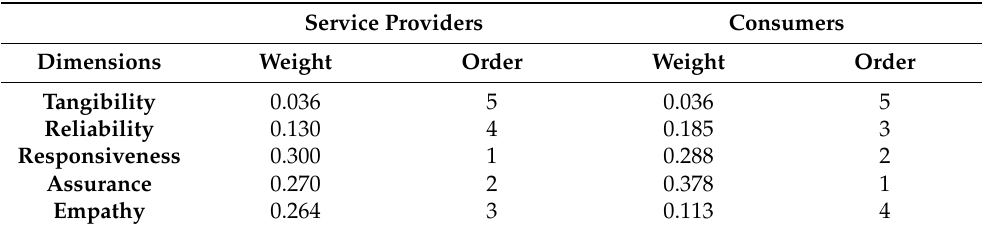
Table 8. Weights and orders of dimensions.